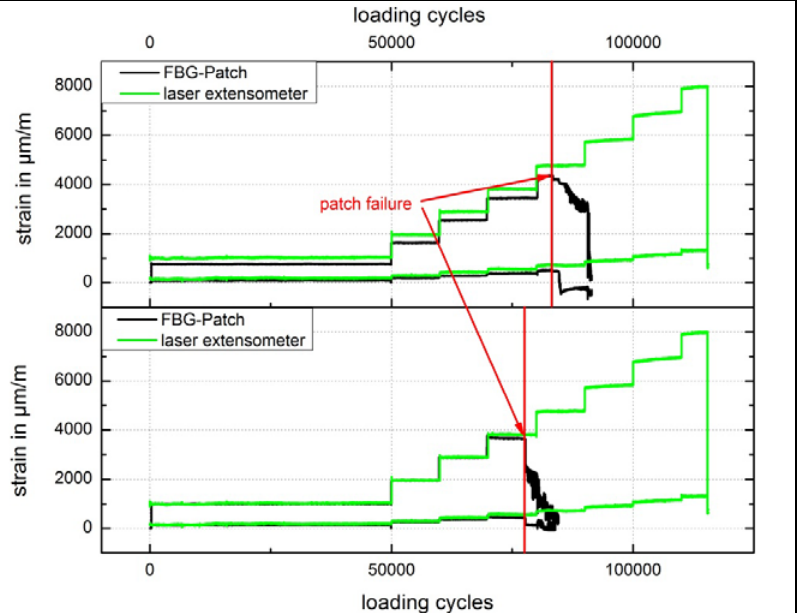
Figure 14. Two patches with embedded bare FBG were applied on the front and back of a specimen and loaded during tensile fatigue tests. Both patches failed clearly before reaching beginning crack initiation of the specimen.